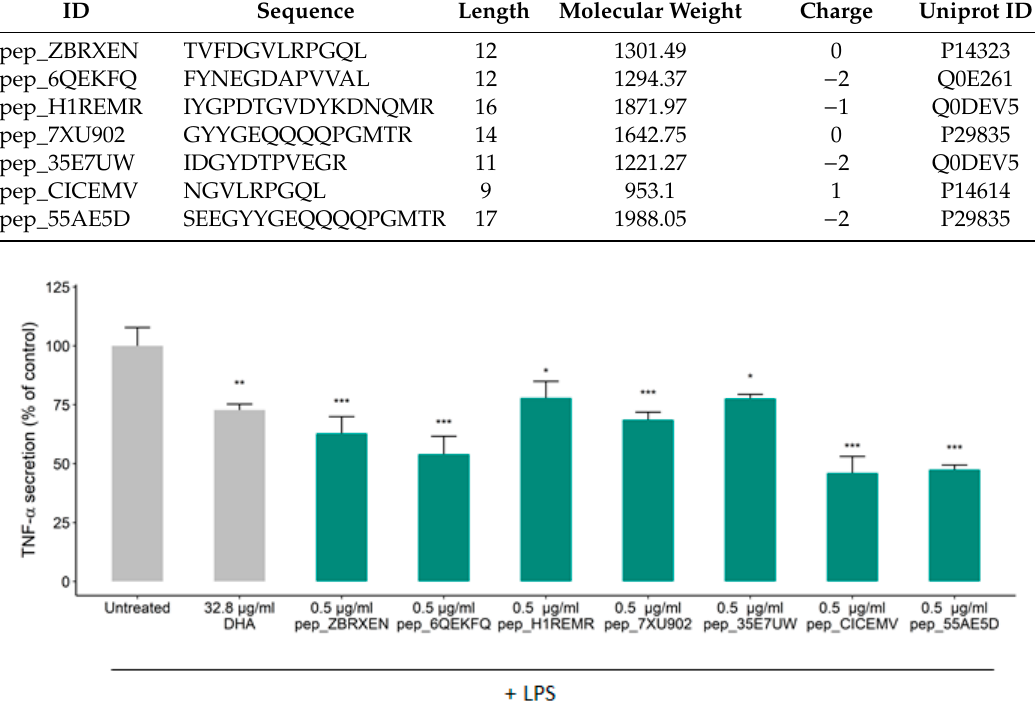
Figure 3. Effects of rice NPN constituent peptides on TNF- α secretion from differentiated THP-1 macrophages. Effect of treatment on the secretion of TNF- α in THP-1 differentiated macrophages after treatment with LPS. THP-1 macrophages were treated with predicted peptides (0.5 μ g/mL), or media alone (Untreated) for 24 h before incubation with 100 ng/mL of LPS for 24 h. The secretion of TNF- α was quantified by ELISA. Data presented are the mean ± SEM of at least 3 independent experiments (* p < 0.05, ** p < 0.01, *** p < 0.001).